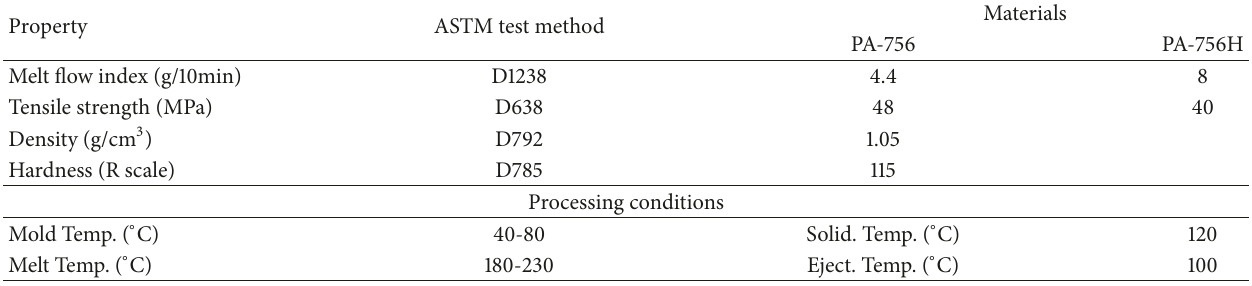
Figure 5: (a) Photograph of dual-cavity injection mold, (b) geometrical dimensions of dumbbell specimen, and (c) photograph of injection- molded part. Table 3: Material properties and recommended processing conditions.